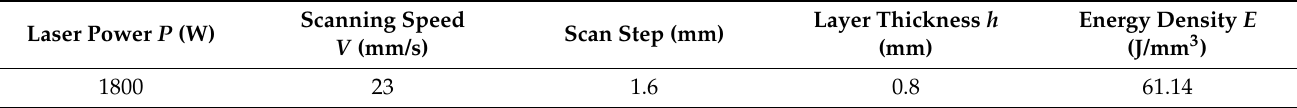
Table 3. Technological parameters of scanning.